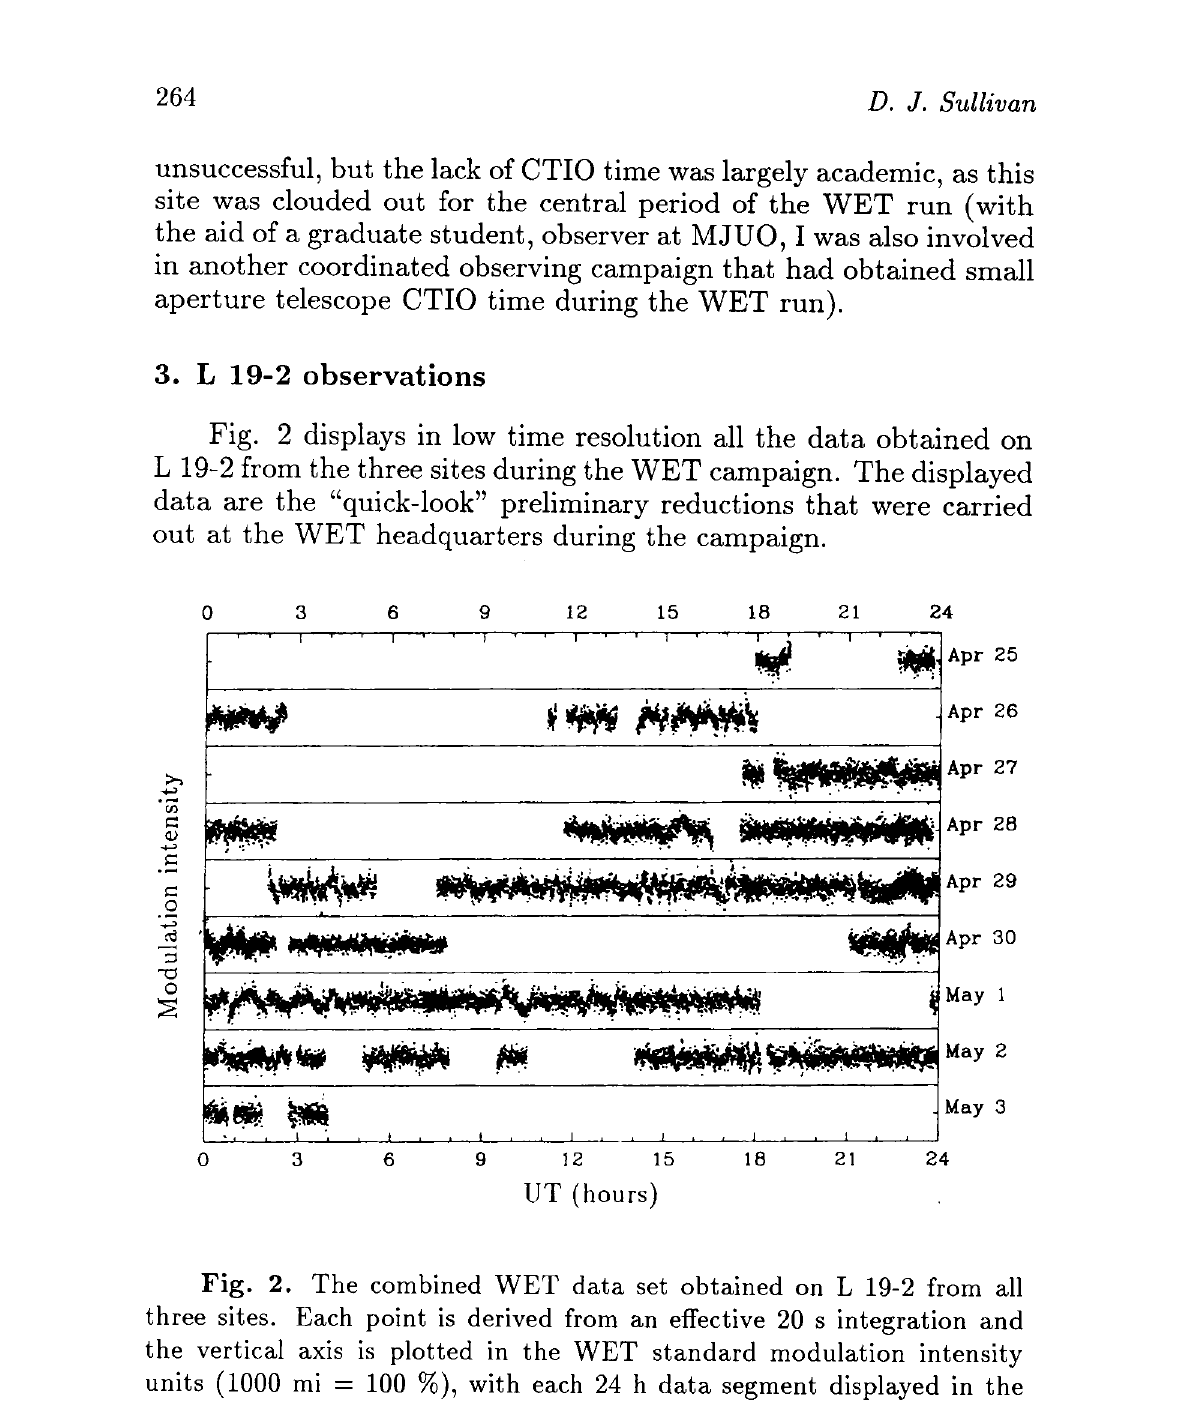
Fig. 2. The combined W ET data set obtained on L 19-2 from all three sites. Each point is derived from an effective 20 s integration and the vertical axis is plotted in the W ET standard modulation intensity units (1000 mi — 100 %), with each 24 h data segment displayed in the range ±40 mmi (= ±4 %). MJUO data cover the central time regions of the graph, while data from SAAO and PDDO share the end regions - see Fig.